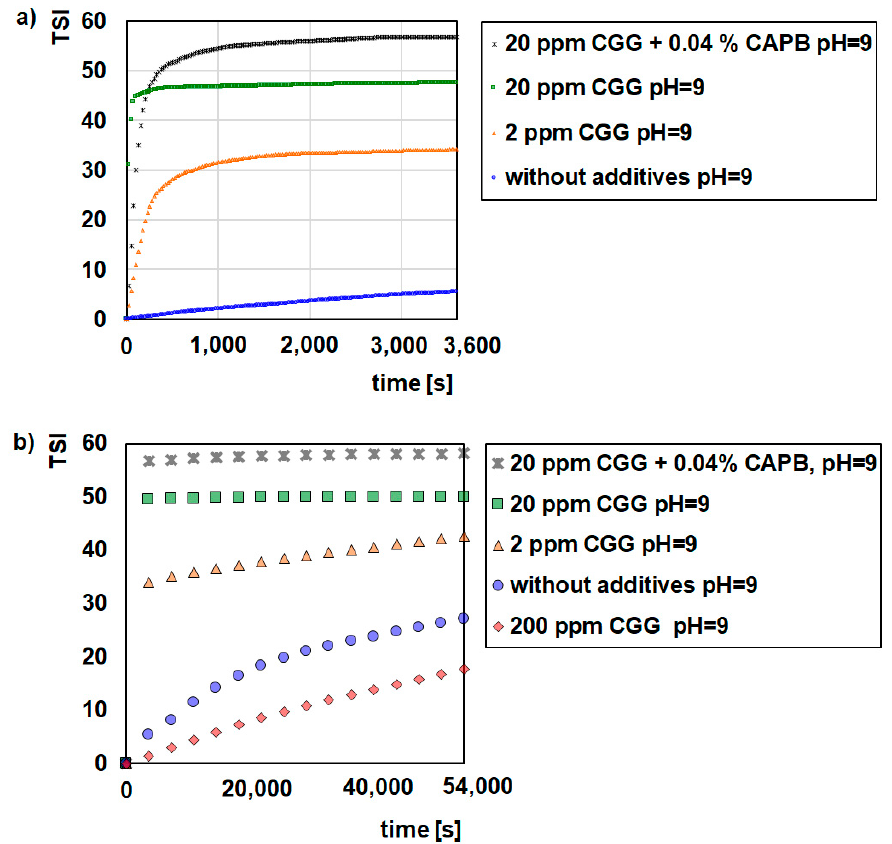
Figure 2 . Influence of CGG with the addition of 0.04% CAPB on stability of the glauconite suspensions at pH = 6; 1 h ( a ), 15 h ( b ).